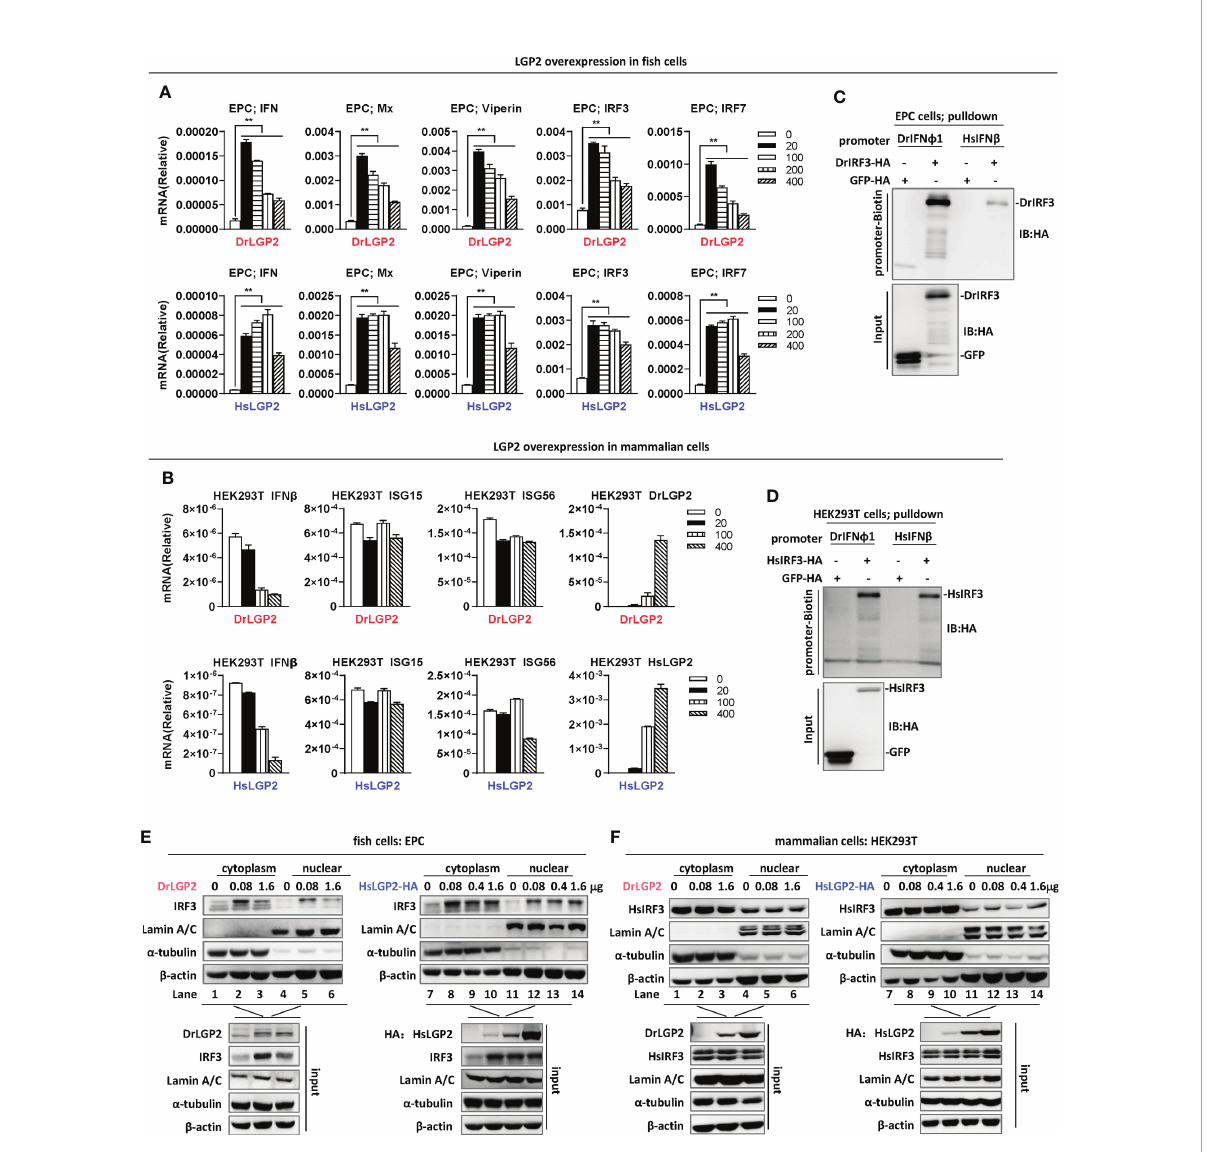
FIGURE 2 Overexpression of zebra fi sh or human LGP2 induces IFN response in fi sh cells but not in mammalian cells (A, B) RT-PCR analysis of transcriptional levels of IFN and ISGs induced by DrLGP2 and HsLGP2 in EPC cells (A) and HEK293T cells (B) . EPC cells (A) and HEK293T cells (B) seeded overnight in 12-wells plates were transfected with DrLGP2 or HsLGP2 at increasing doses (0, 20, 10, 200, 400 ng) for 24 h, followed by RT-PCR detection of cellular gene transcription. P values were calculated using ANOVA. ** P < 0.01. (C, D) DNA pull-down assays veri fi ed the binding of DrIFN j 1 and HsIFN b promoter DNA to DrIRF3 in EPC cells (C) and HsIRF3 in HEK293T cells (D) . EPC cells (C) and HEK293T cells (D) seeded in 10 cm dishes were transfected with DrIRF3-HA (C) or HsIRF3-HA (D) . GFP-HA was transfected in parallel as control. 24 h later, cells were lysed. One-tenth of cell lysates were taken as input, and the remaining was incubated overnight with 100 ng biotinylated DrIFN j 1 promoter DNA (-596 to +38) (C) or HsIFN b promoter DNA (-338 to +93) (D) . The DNA-bound protein complexes were detected by western blots with anti-HA antibody. (E, F) overexpression of LGP2 increased nuclear IRF3 protein levels in fi sh cells but not in mammalian cells. EPC cells (E) and HEK293T cells (F) seeded in 5 cm dishes were transfected with DrLGP2 or HsLGP2 at increasing doses. 24 h later, cells were collected for nuclear and cytoplasmic separation, followed by western blot analyses of the indicated proteins using corresponding antibodies. The expression of Lamin A/C and a -tubulin veri fi ed the successful separation of nuclear and cytoplasmic